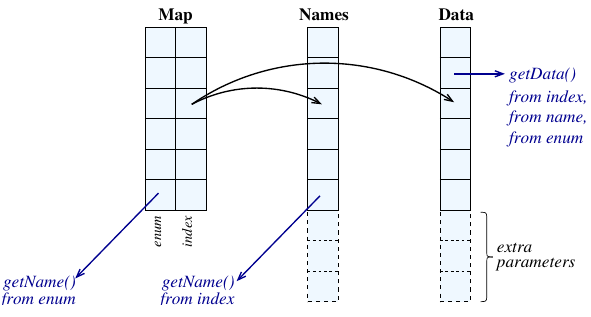
Figure 3. Meteorological data set internal